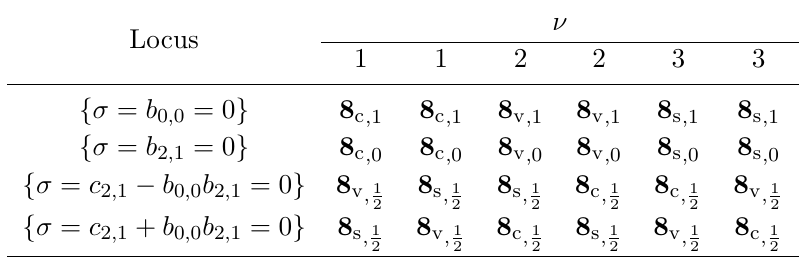
Table 15. Matter representations supported at the four codimension-two I ∗ s fibration of eq. (8.17). Because of the triality of so (8) , there are multiple ways of describing the supported matter representations. Each column corresponds to one choice of matter representations and ν